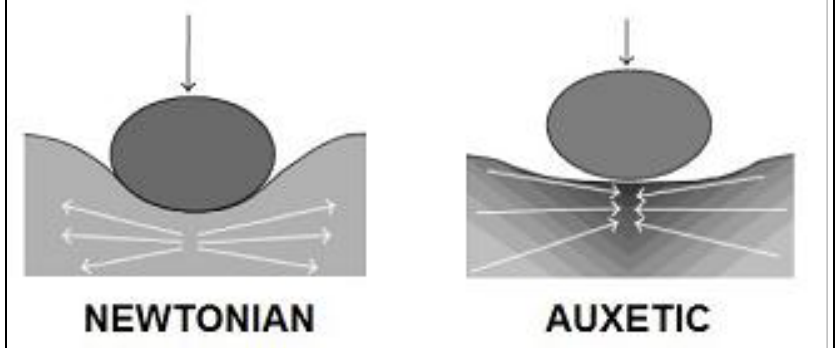
Figure 6. Indentation behaviour of a Newtonian and auxetic material